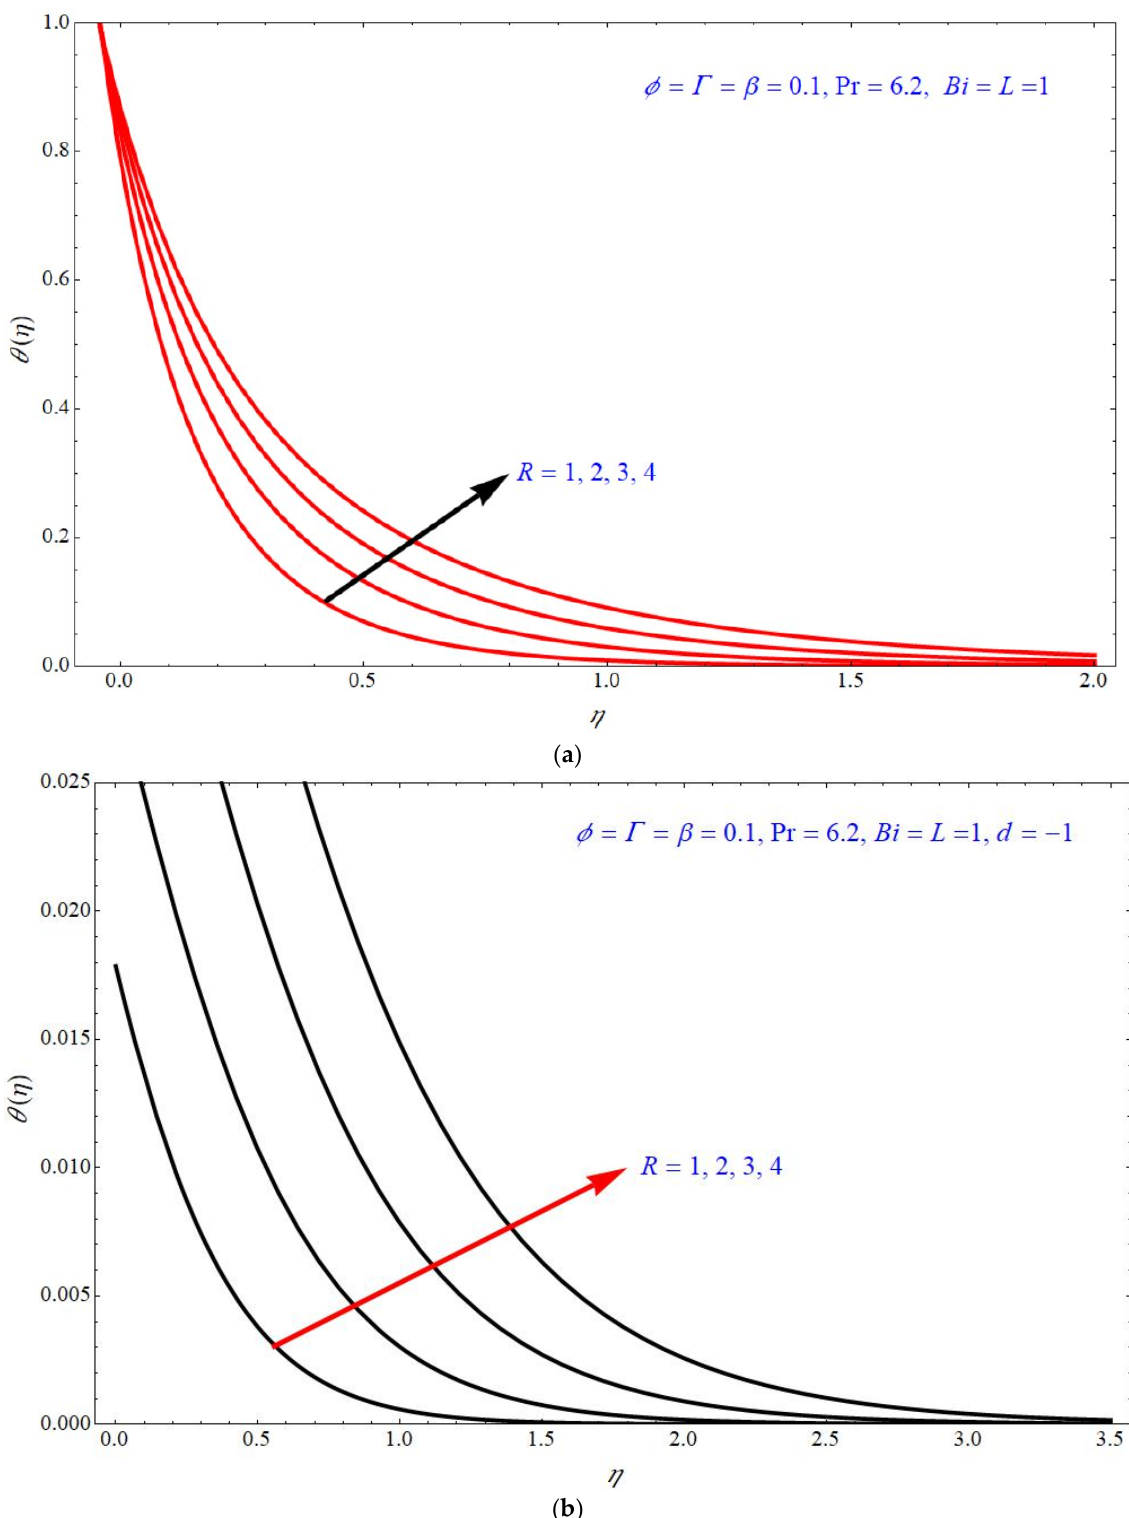
= − . Figure 5. Impact of θ ( η ) on η for various choices of R at ( a ) d = 1 and ( b ) d = −